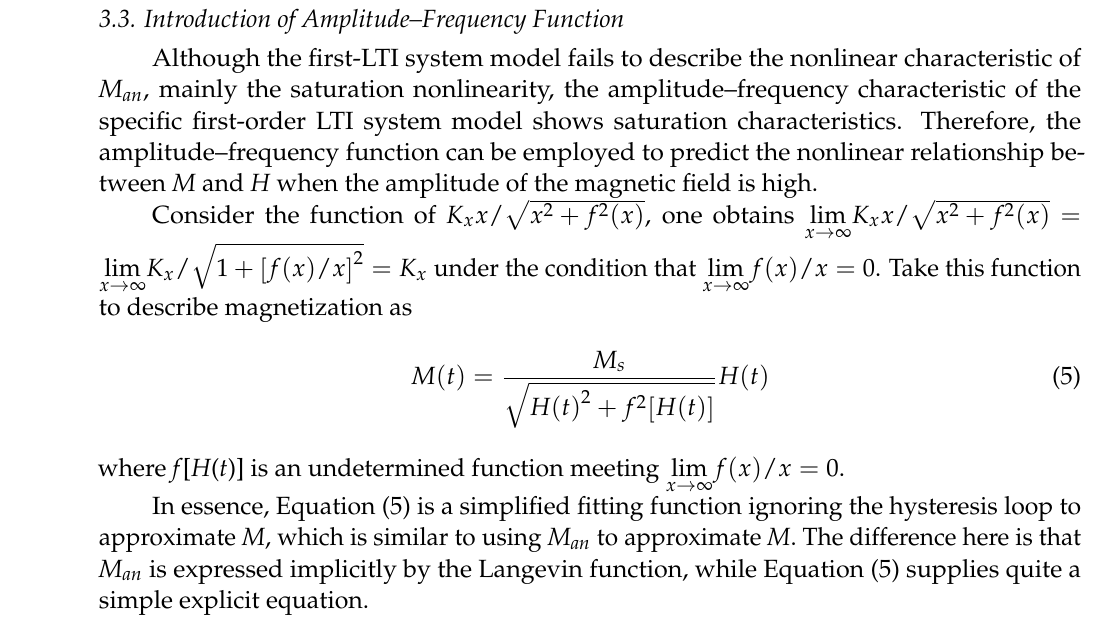
Figure 6. Magnetization curves under high magnetic field intensity calculated from the Jiles–Atherton model and the 1st − order LTI system model: ( a ) time − domain curves; ( b ) M − H curves.